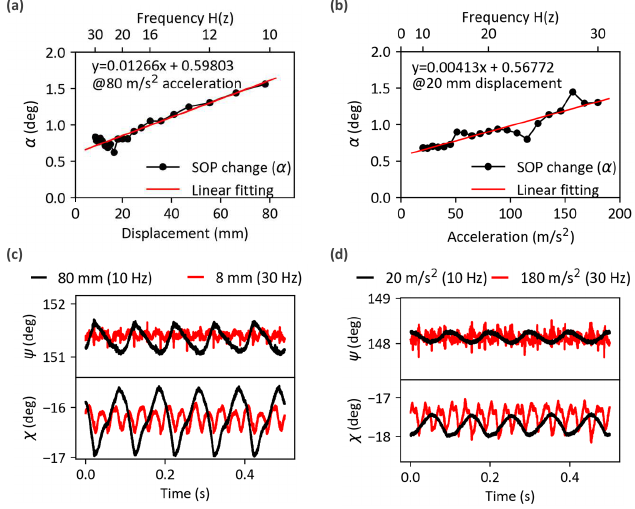
Figure 6. Measured SOP changes ( a ) when the displacement change was applied with a constant acceleration and ( b ) when the acceleration change was applied with a constant displacement. SOP variations were measured as changes in elevation angle ( χ ) and azimuth angle ( ψ ) ( c ) when applying two different displacement values (80 mm (black) and 8 mm (red) with a constant acceleration of 80 m/s 2 ) and ( d ) when applying two different accelerations (20 m/s 2 (black) and 180 m/s 2 (red) with a constant displacement of 20